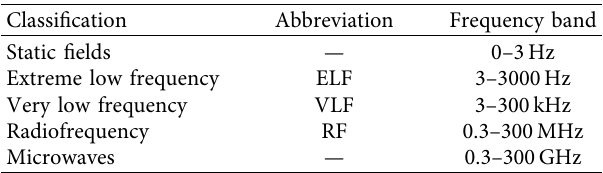
Table 1: Classification bands for low-frequency electromagnetic